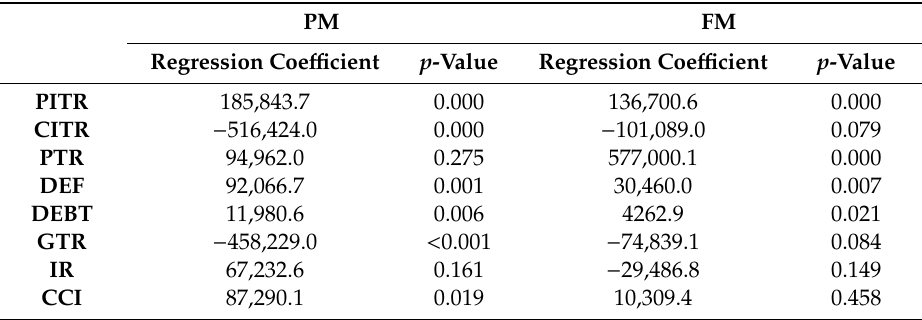
Table 3. Estimated models for the third group of countries.